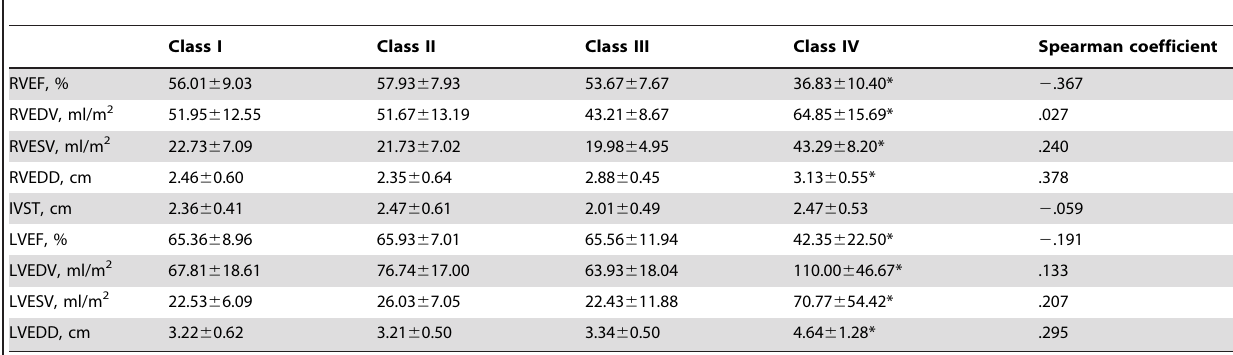
Table 3. Function and size parameters in different NYHA classifications.